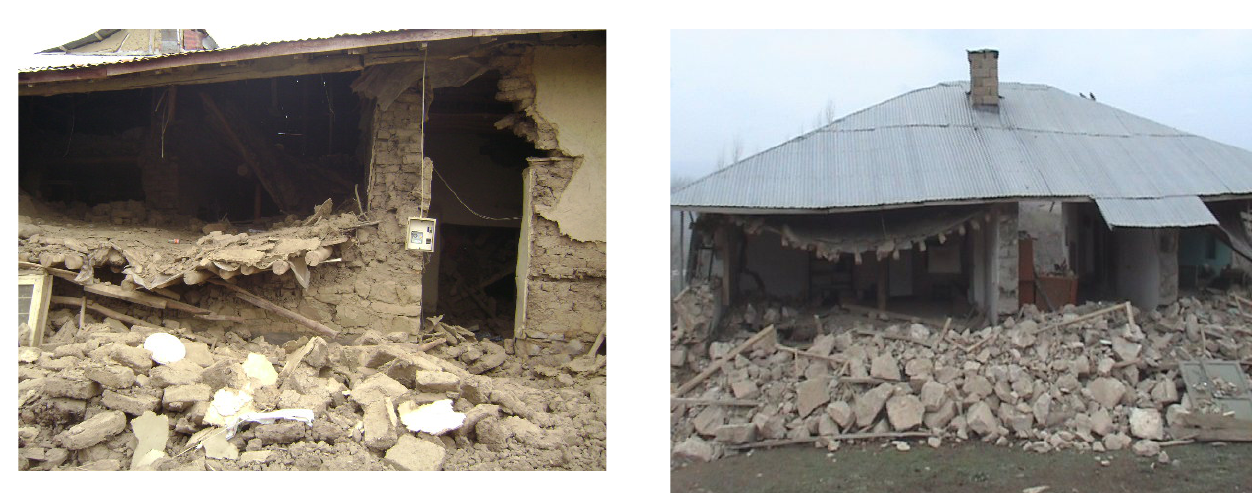
Fig. 7. No connection to partition walls.